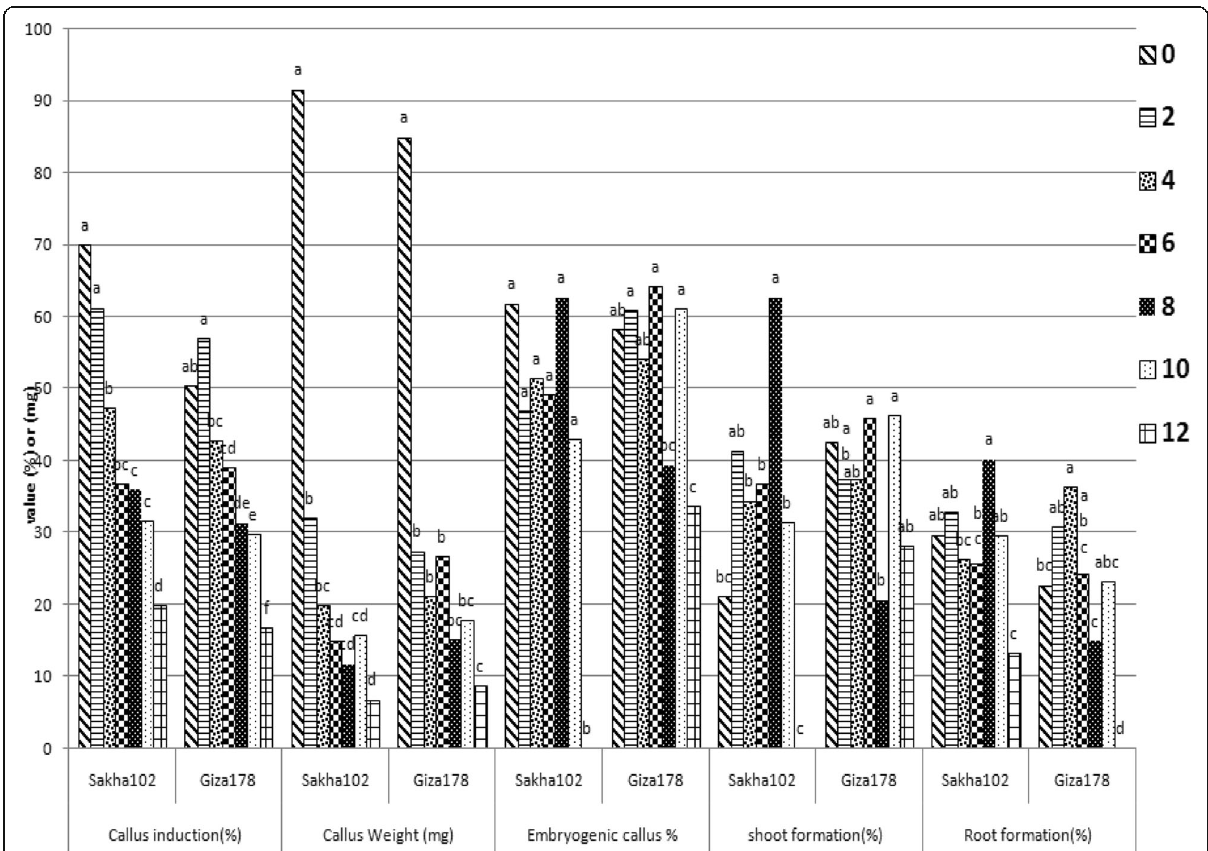
Fig. 2 Callus induction, callus weight, embryogenic callus, shoot formation, and root formation of rice cultivars transferred to MS after tow subcultures treatment with various A concentration. Bars with different lower case letters indicate a significant difference by LSD test ( p <